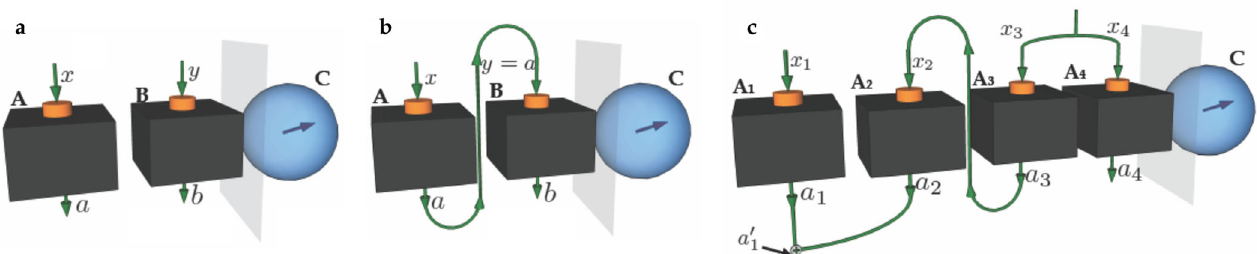
Fig. 1 Several hybrid (trusted-untrusted) multipartite scenarios. In the device-dependent (DD) case, measurement devices are well characterized (trusted), so that a speci fi c quantum state (represented by Bloch spheres) can be attributed to the system. In the device- independent (DI) case, in contrast, the devices are uncharacterized (untrusted), so that systems are represented by black boxes. Semi-DI scenarios contain both trusted and untrusted components. There, the joint system is mathematically described by a hybrid object — intermediate between a state and a Bell behavior — called assemblage , and the type of nonlocality they can feature is called steering . In all three panels the shaded plane illustrates the bipartition of the trusted subsystem versus the untrusted ones. a An assemblage in the 2DI + 1DD scenario: Alice and Bob rely on a black-box description, whereas Charlie ’ s system is trusted. All three subsystems are space-like separated. b Alice and Bob are no longer space-like separated: she communicates her output to him and he uses this to choose his input. This is an example of a bilocal wiring (local with respect to the bipartition AB ∣ C ). Such operations cannot create any correlations across the bipartition, but they can expose a subtle form of multipartite quantum nonlocality that otherwise does not violate any Bell or steering inequality across the bipartition (see text). c A 4DI + 1DD assemblage is mapped onto a 2DI + 1DD one by a bilocal wiring ( x 2 = a 3 , x 3 = x 4 , and a